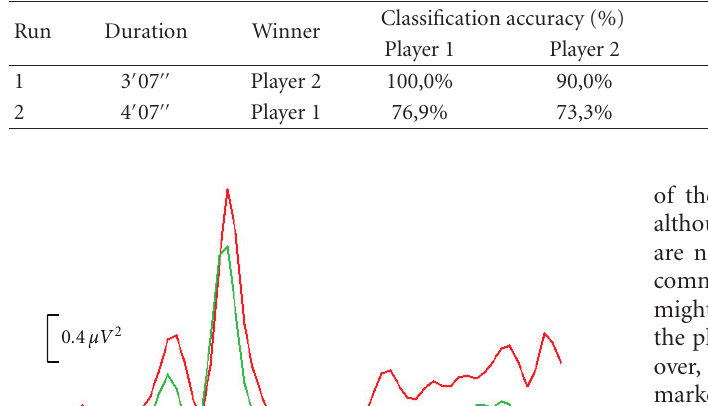
Table 2: Detailed results for the two games in contest mode.